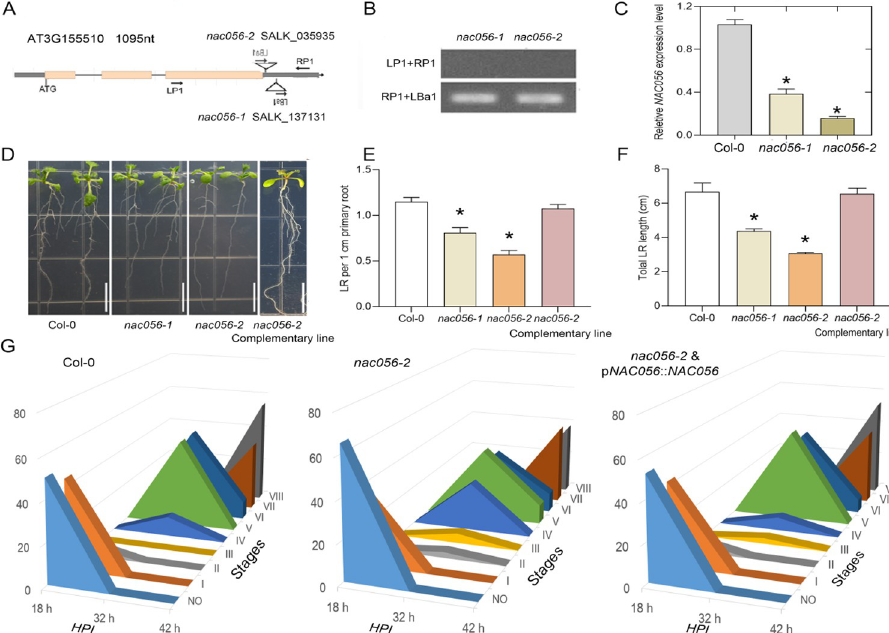
Fig 2. Altered root development in the nac056 mutant. A. The genomic organization of the NAC056 gene. The yellow boxes show the positions and sizes of the exons. The triangle indicates the site of a T-DNA insertion. The genomic sequence used to complement the nac056 mutation is indicated. B. Identification of homozygous NAC056 mutants. C. The mRNA abundance of the NAC056 gene in the roots was measured in nac056 mutant backgrounds, using reverse transcription-quantitative PCR (RT-qPCR). D. Root phenotypes of wild-type (WT) plants, the nac056 mutants, and complemented mutant lines. The plants were grown vertically on medium for 8 d. Bar indicates 1 cm. (E) LR density and (F) total LR length analysis in the Col-0, nac056 mutant, and nac056 complemented mutant lines. The error bars denote the standard errors (SEs) (n = 6–8). G. Phenotypic analysis of LR emergence (LRE) was achieved by synchronizing LR formation with gravitropic stimulus for 18, 32 or 42 h. Compared with the WT, the nac056-2 mutant showed delayed LRE. Mutant plants transformed with the full-length NAC056 genomic fragment exhibited a WT LRE phenotype for LR induction. The data are shown as percentages, and the error bars represent SEs (n = 10–16). At least 100 total LRPs were observed for each plant. Each data point represents the mean ± SE (n = 4). � p < 0.05 by Student’s t